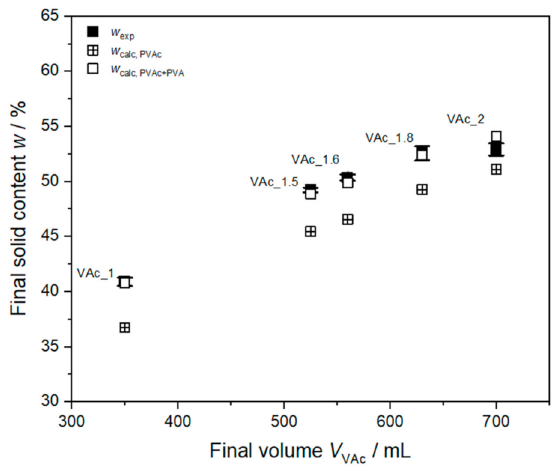
Figure 2. Final experimental solid content of all syntheses (full squares) in dependency of the total dosed volume of monomer V VAc compared to the calculated solid content for 100% monomer to polymer conversion w calc, PVAc (crossed squares) and calculated solid content for 100% conversion of monomer to polymer and attachment of the total amount of PVA to the particle w calc, PVAc+PVA (open squares).